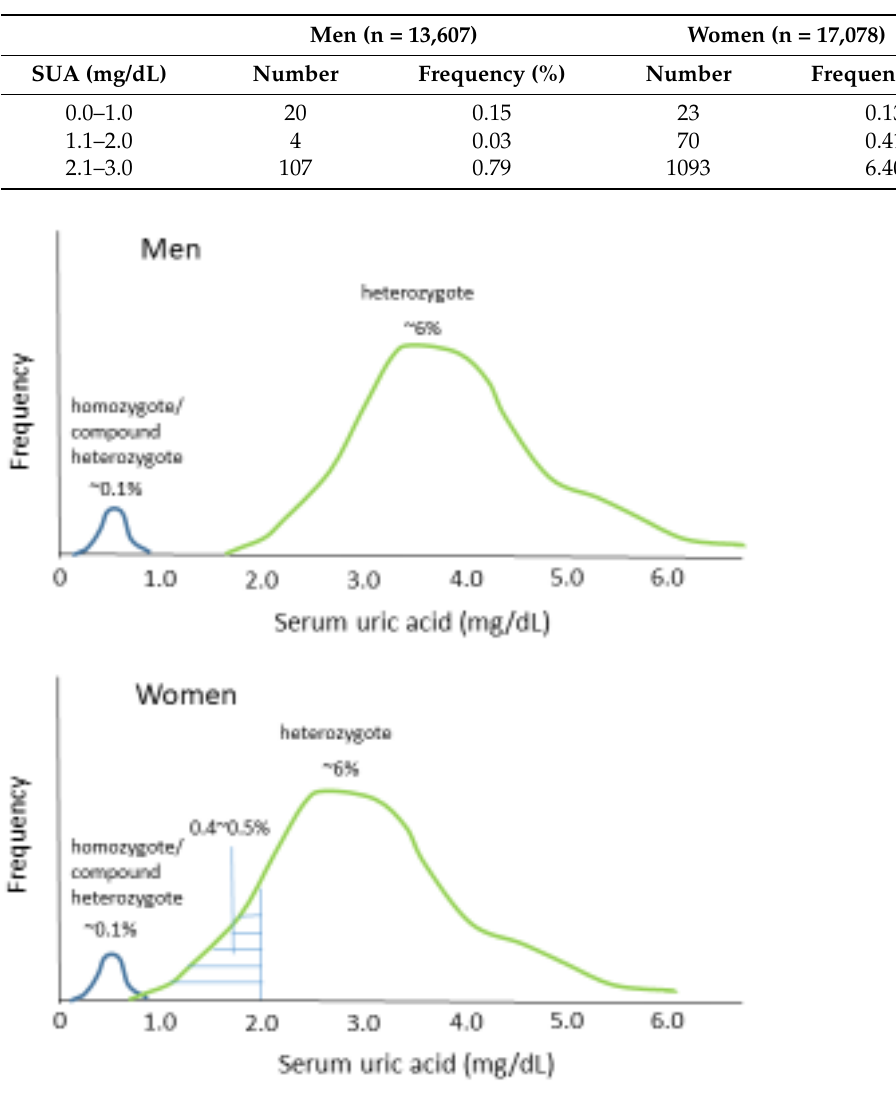
Figure 1. Distribution of serum uric acid concentrations in men and women with a homozy- gous/compound heterozygous URAT1 mutation and those with a heterozygous URAT1 mutation. Another cause of RUHC is a genetic defect in GLUT9 , which encodes a protein that transports reabsorbed UA from the proximal tubular cells into circulation (RHUC type 2, OMIM:612076) [21]. GLUT9 mutations seem to cause a more severe defect in UA re- absorption in the kidney than URAT1 mutations because the FEUA is sometimes >100% in patients with the former [21]. Matsuo et al. screened the genomic sequence of the GLUT9 gene in 70 Japanese individuals with an SUA concentration ≤ 3.0 mg/dL and found two mutant GLUT9 alleles (the URAT1 W258X allele was identified in 47 out of 70 indi- viduals) [7]. These GLUT9 mutant alleles were not identified in 130 randomly